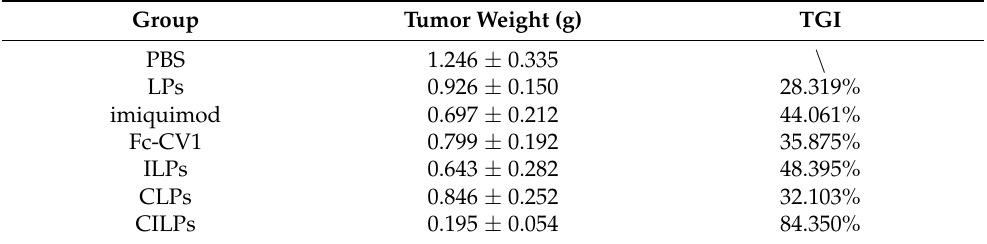
Table 2. The data of tumor weight and tumor growth inhibition (TGI) of various treatment groups. Group Tumor Weight (g) TGI PBS